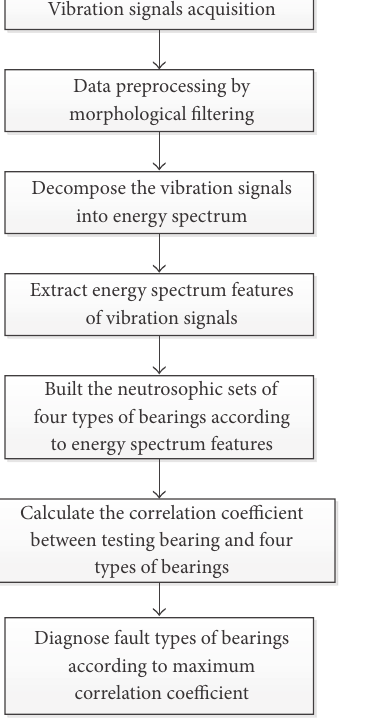
Figure 3: Block diagram of diagnosis for fault bearing using neutrosophic